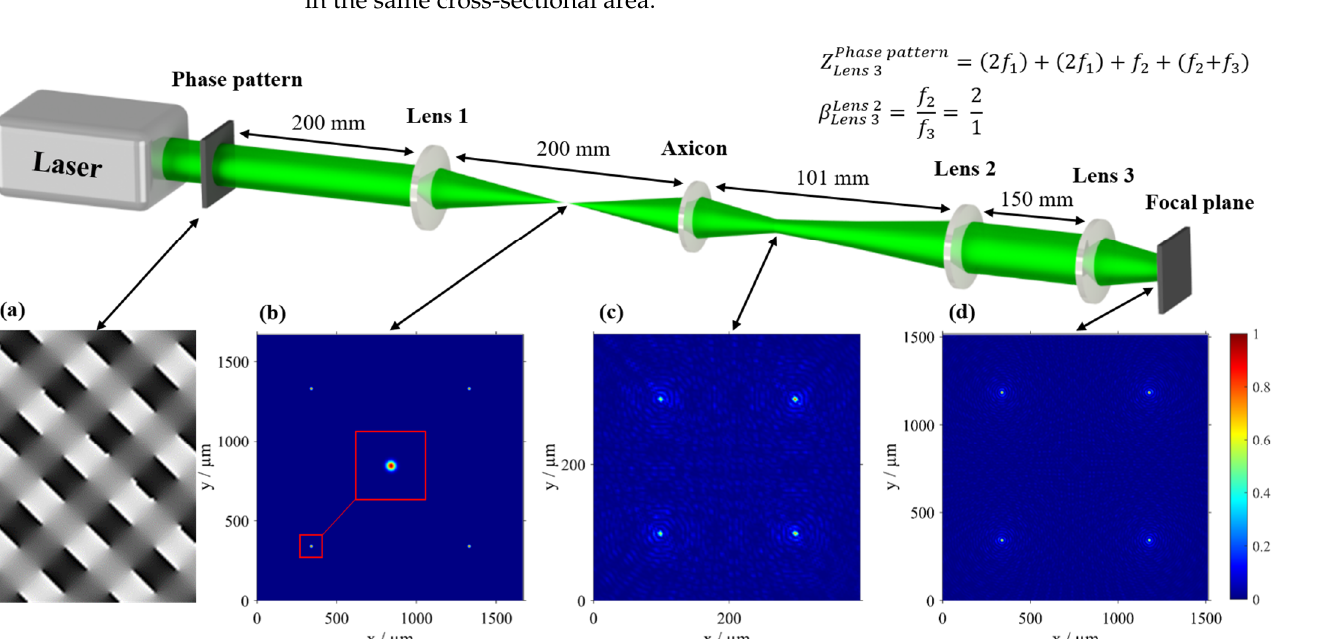
  in the shown  in the shown formula Lens 3 indicates the Lens 3